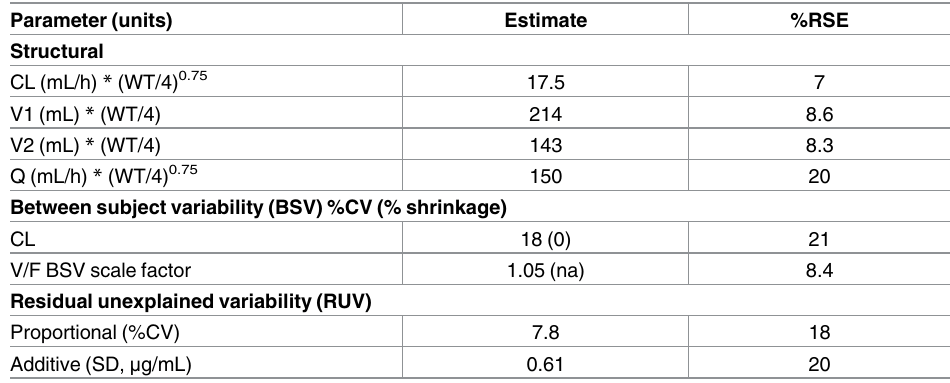
Table 1. Population pharmacokinetic parameters for caspofungin in cats.